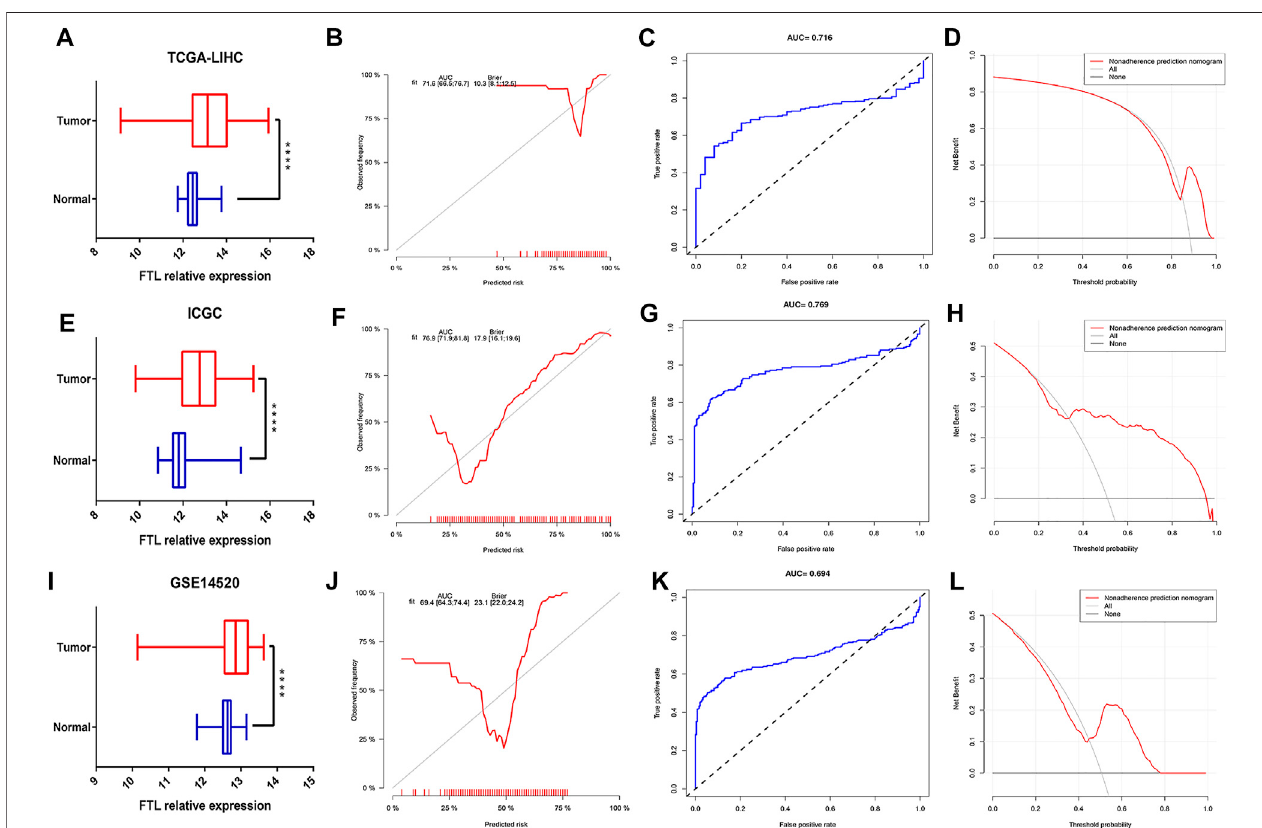
FIGURE 4 | Measurement of FTL expression in tumor samples compared with normal samples and evaluation of the diagnostic ability of FTL in HCC. (A,E,I) Box plot showing the FTL mRNA expression level in normal and tumor tissues in HCC from the TCGA-LIHC cohort, ICGC-HCC cohort, and GSE14520 cohort. (B,F,J) Calibration curves indicating the diagnostic ability of FTL in HCC patients from the TCGA-LIHC cohort, ICGC-HCC cohort, and GSE14520 cohort. (C,G,K) ROC curves assessingthepredictiveperformanceofthediagnosticmodelintheTCGA-LIHCcohort,ICGC-HCCcohort,andGSE14520cohort. (D,H,L) DCAcurvesvalidating the predictive potency of the diagnostic model in the TCGA-LIHC cohort, ICGC-HCC cohort, and GSE14520 cohort. **** p <